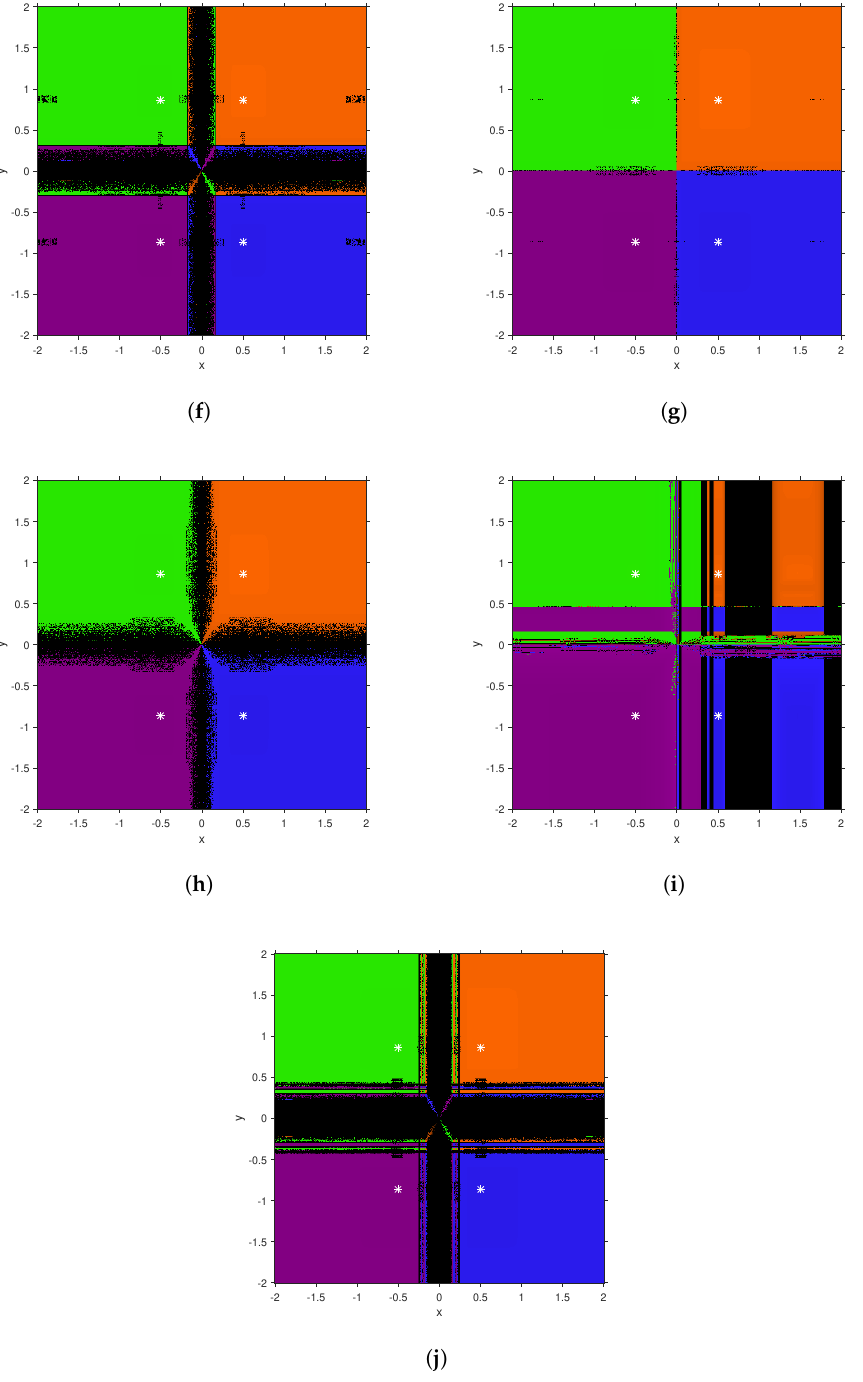
Figure 2. Basins of attraction of known and proposed methods on G ( x 1 , x 2 ) = 0. ( a ) H 6,1 ; ( b ) H 6,2 ; ( c ) H 6,3 ; ( d ) H 6,4 ; ( e ) H 9,1